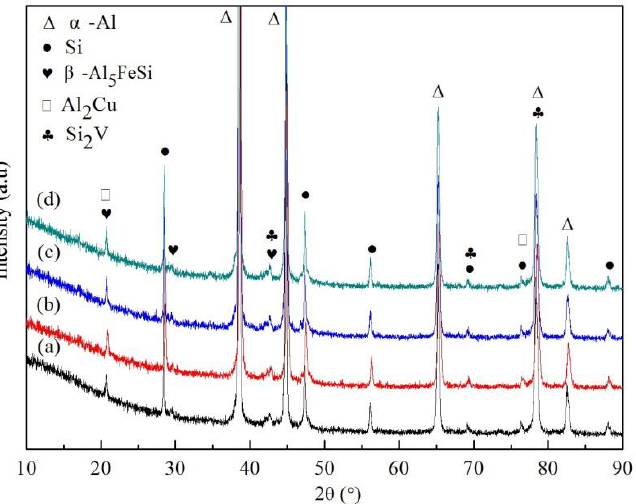
Figure 4. X-ray diffraction (XRD) patterns of as-cast gravity casting alloys with different vanadium contents: ( a ) A1 alloy; ( b ) A2 alloy; ( c ) A3 alloy; ( d ) A4 alloy.